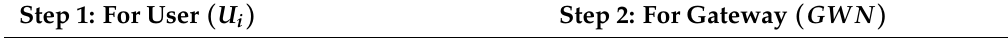
Table 4. Authentication and session key establishment phase of Choi et al.